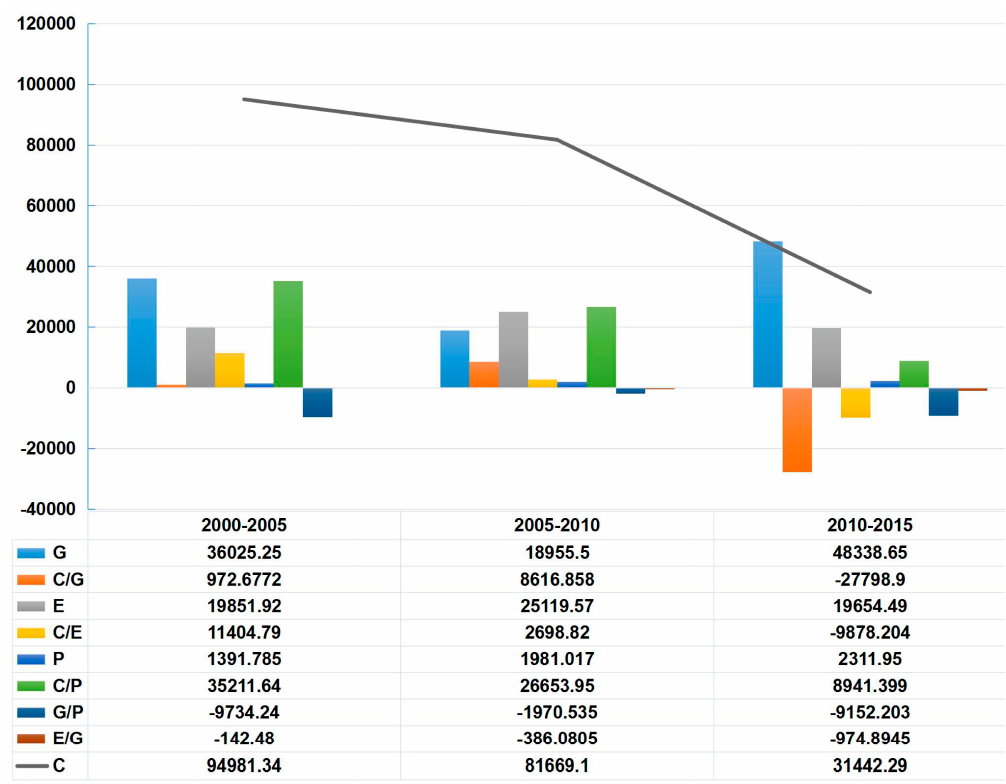
Figure 2. Stages of the decomposition of carbon emissions in the electricity industry. Unit: 10 4 tons.